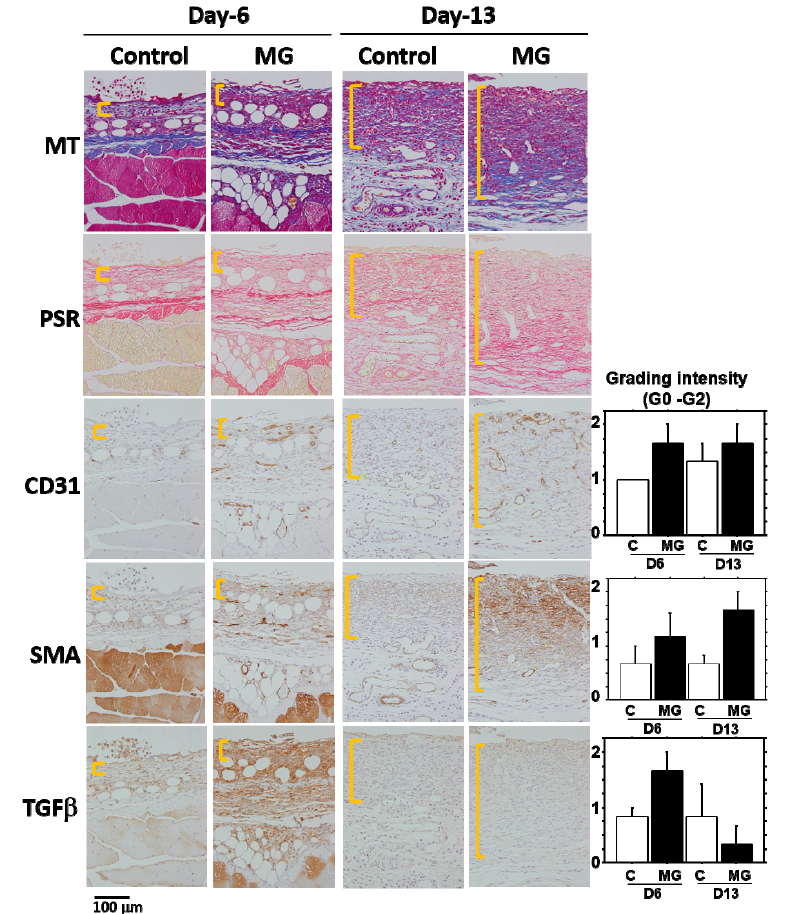
Figure 7. Histological alterations after micrograft. The representative pictures of granulation tissue marked by yellow lines are shown on Days 6 and 13 in the control and MG groups. Different connective tissue stains (MT and PSR) and immunohistological stains (CD31, α SMA and TGF- β 1) were performed on serial sections. Scale bar = 100 μ m. Inserted graphs are the semi-quantitative evaluation of CD31, α SMA and TGF- β 1 in each group.